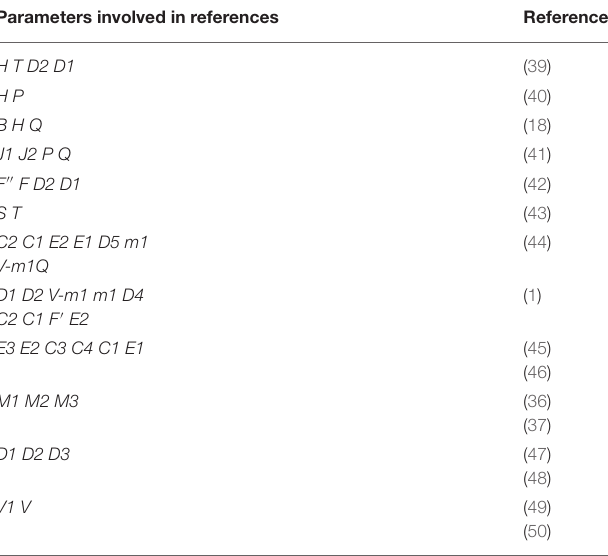
TABLE 1 | Reference source for model